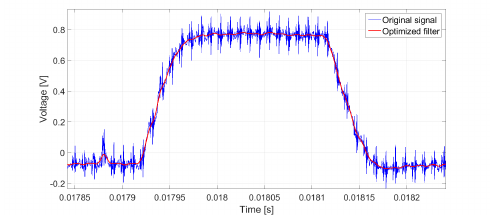
Figure 4. Elastic wave signal with applied